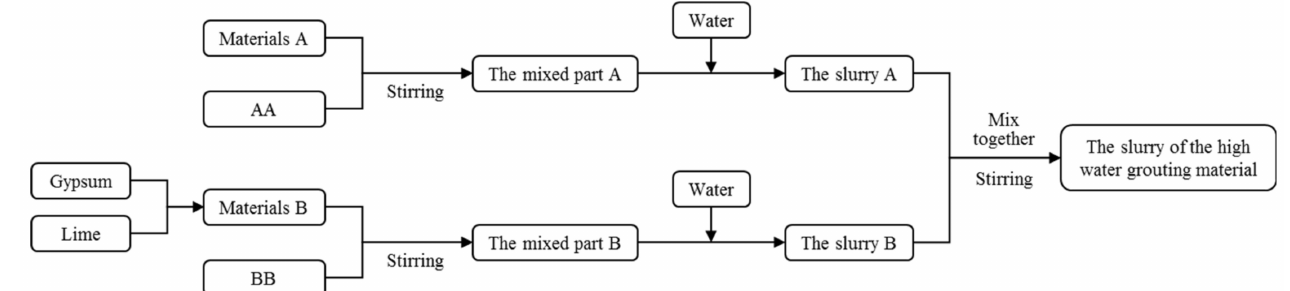
Figure 1. The diagram of sample